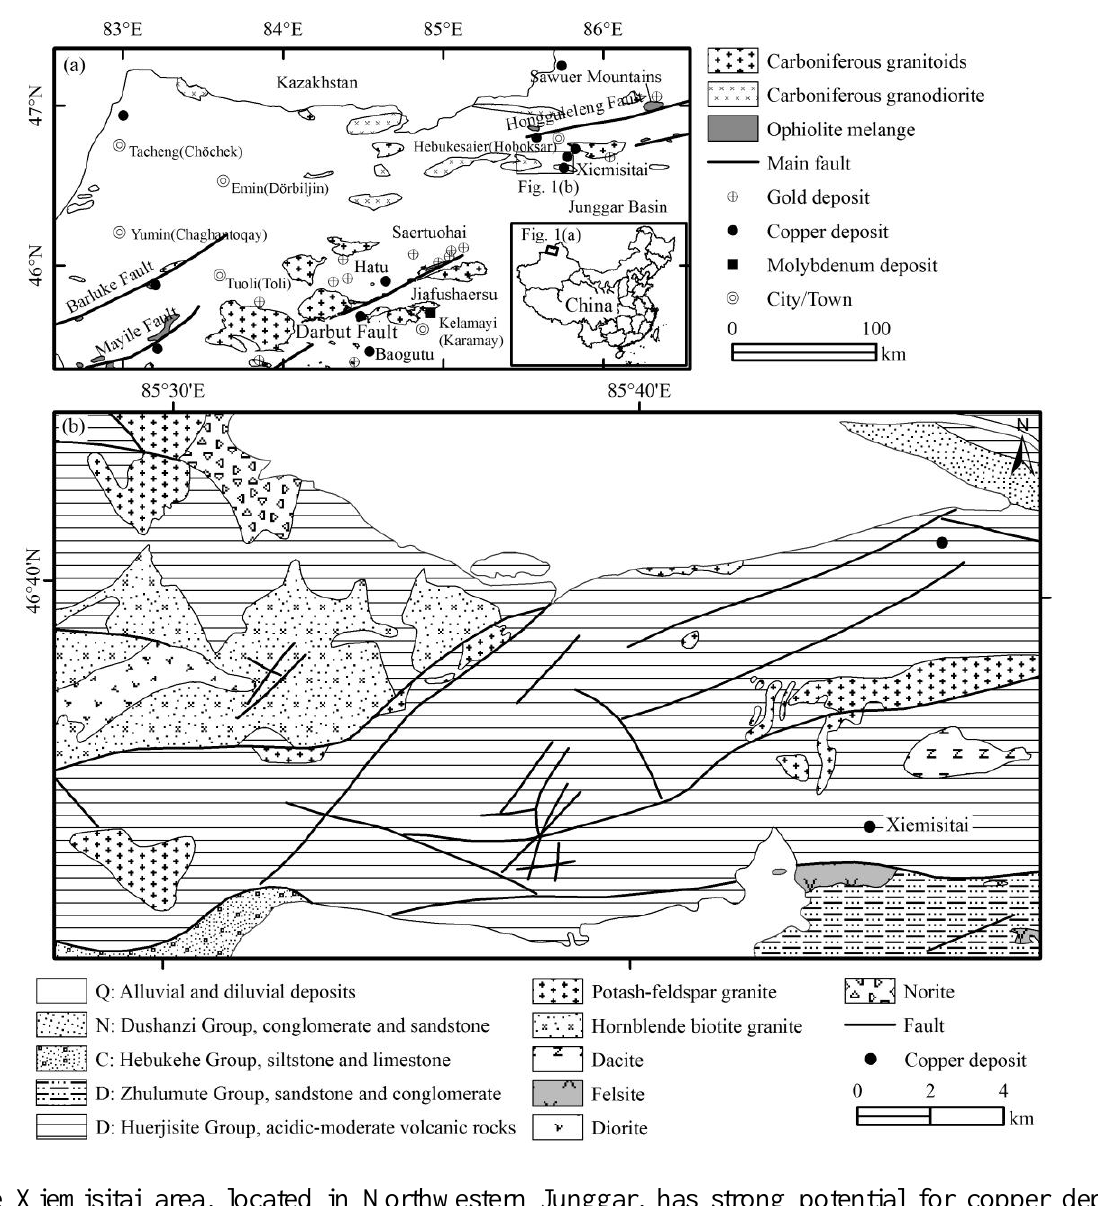
Figure 1. ( a ) Generalized geological map of Western Junggar, NW China, showing the distribution of the intrusions, ophiolite belts and main faults [27]; ( b ) Geological map of the study area after the internally published regional geological maps with codes L-45-VIII and L-45-XIV [30,31]. Q, Quaternary; N, Neogene; C, Carboniferous; D,